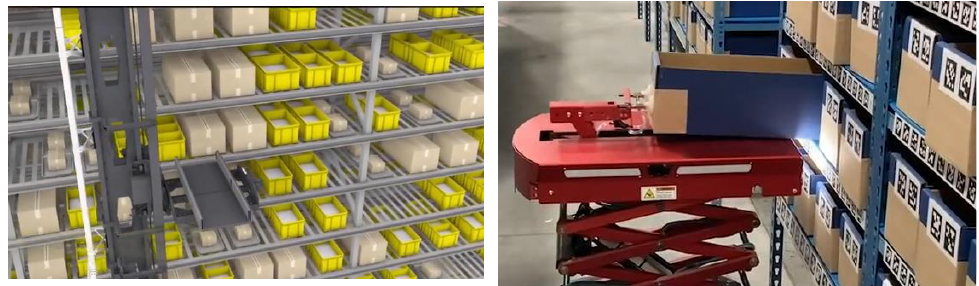
Figure 4. Examples of multiple items in one load unit.